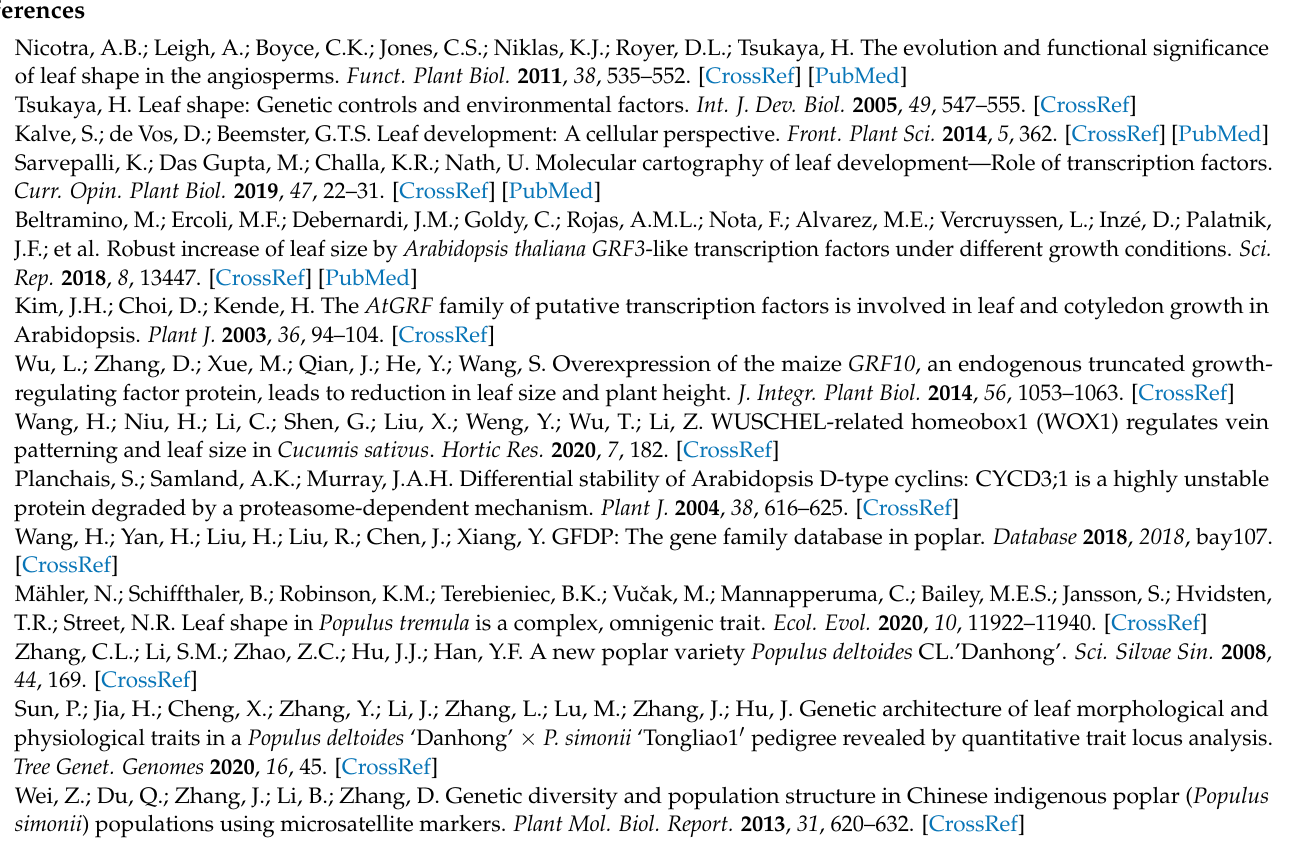
Figure S2: The heat map of cyclin dependent kinases in P. deltoides ‘Danhong’ and P. simonii ‘Tongliao1’, Table S1: Primers used for qRT-PCR experiments, Table S2: Summary of the RNA-seq results, Table S3: The GO enrichement of DEGs between P. deltoides ‘Danhong’ and P. simonii ‘Tongliao1’, Table S4: The KEGG enrichement of DEGs between P. deltoides ‘Danhong’ and P. simonii ‘Tongliao1’, Table S5: DEGs of leaf morphological and physiological traits identified by both QTL mapping and transcriptome, Table S6: The expression profiles of the DEGs related to auxin and gibberellins pathways in P. deltoides ‘Danhong’ and P. simonii ‘Tongliao1’, Table S7: The expression patterns of GRFs and cyclins of Pd and Ps in Figure 4 and Figure S2, Table S8: The expression patterns of secondary wall related